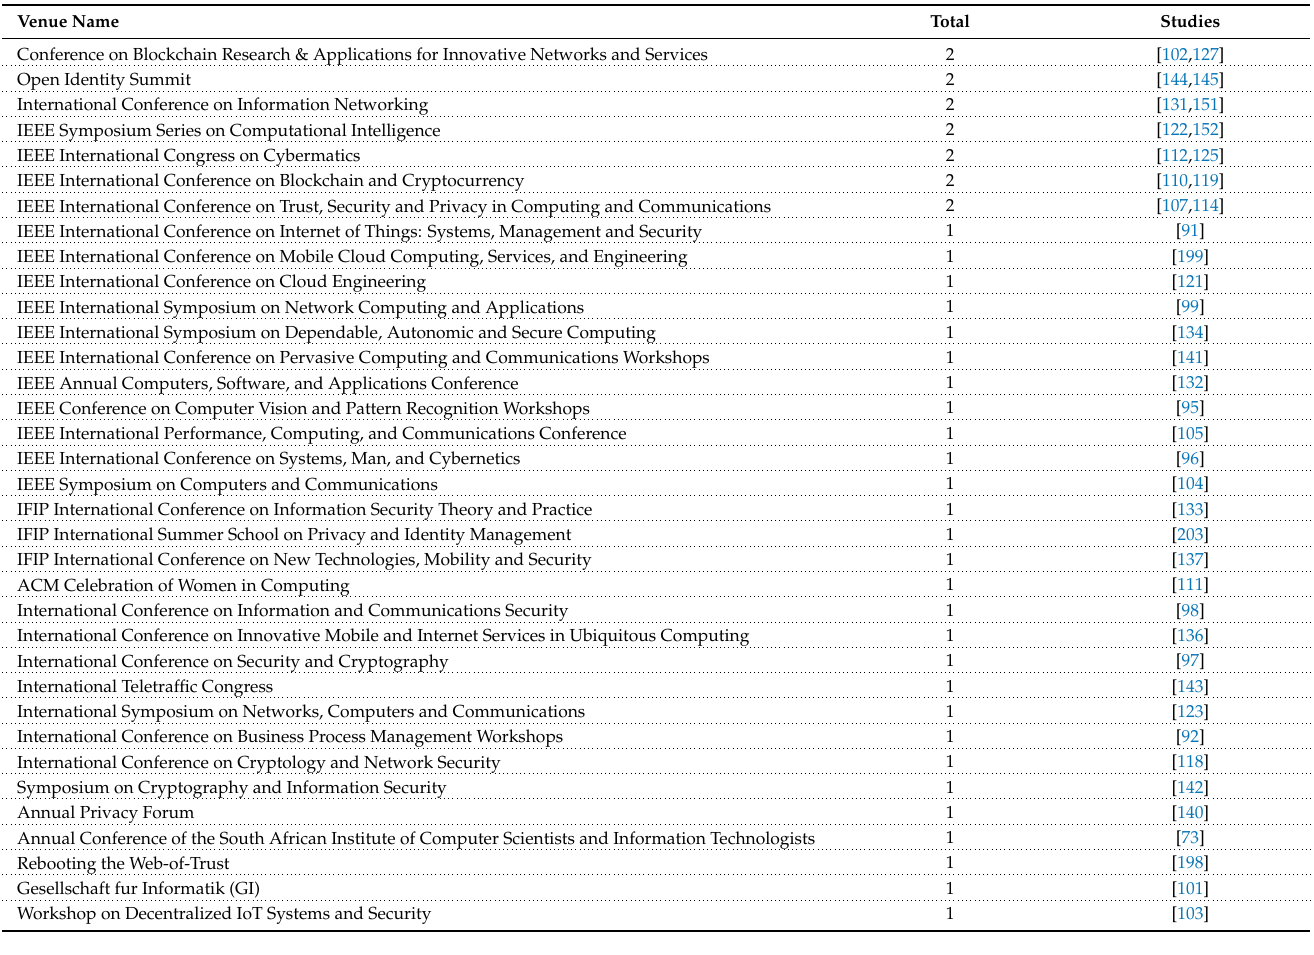
Table A1. Complete list of studies published in conferences, symposia, forums or workshops.